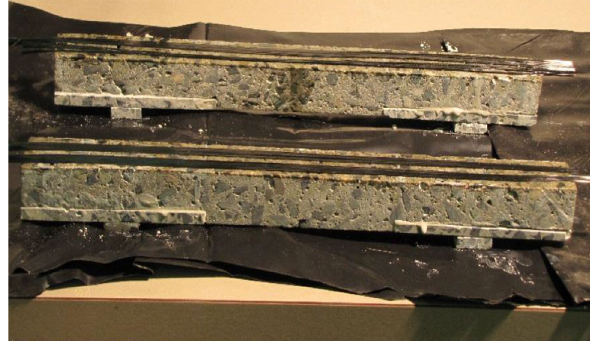
Fig. 5 Completed prototype beams.